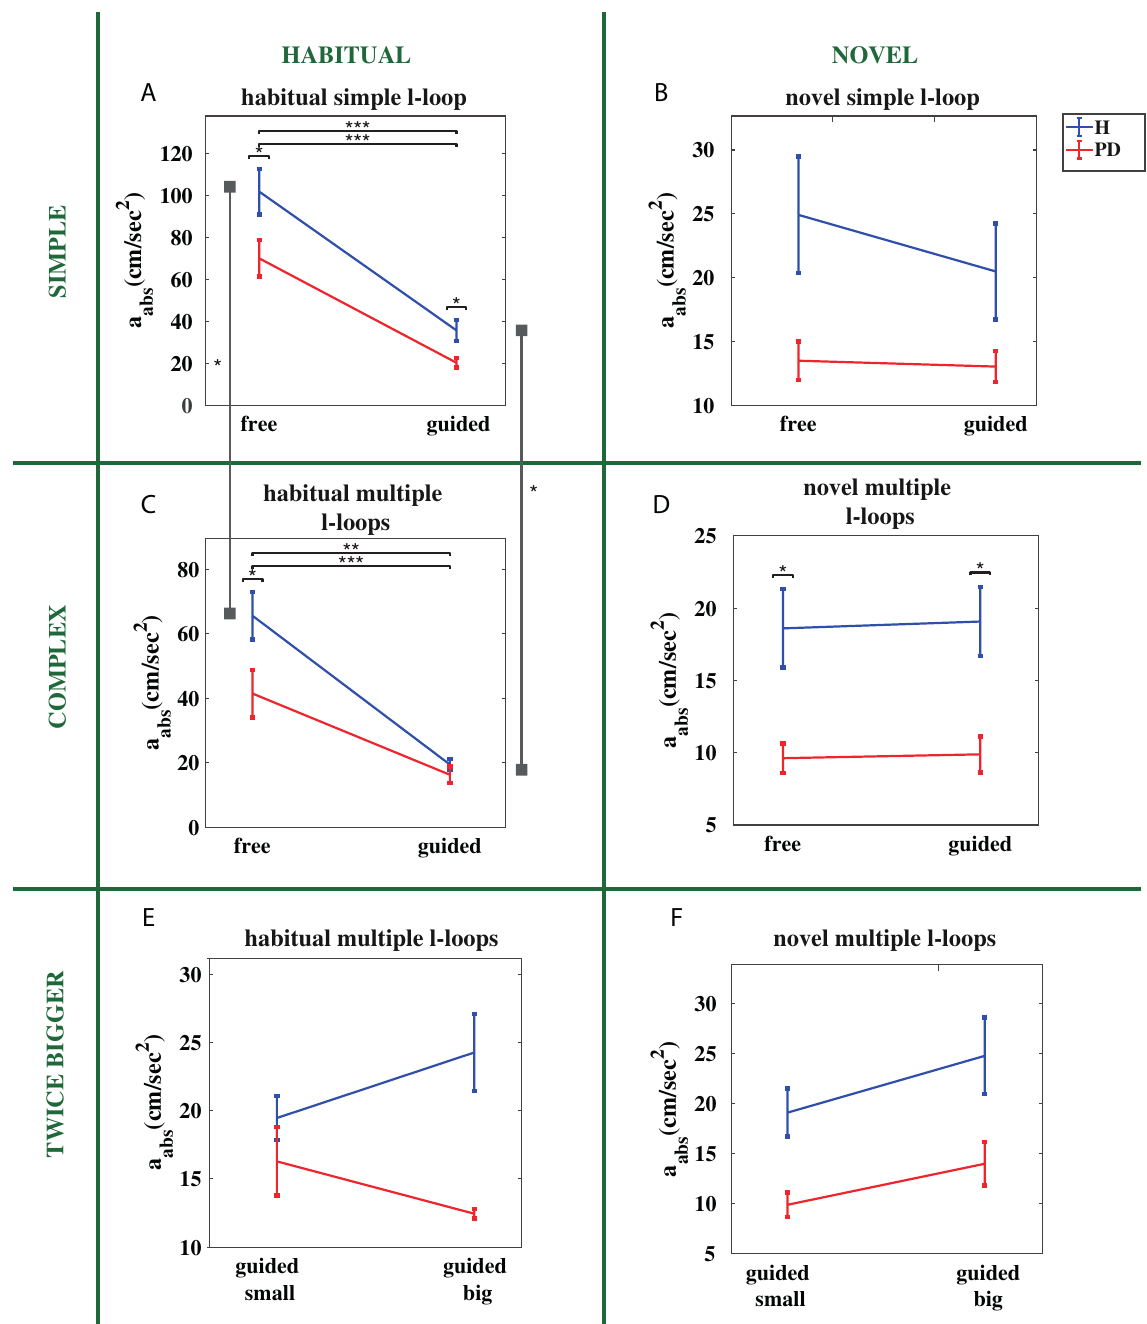
Figure 4. Absolute acceleration (mean ± SEM) across PD patients (red lines) and H subjects (blue lines) for all conditions: ( A ) Habitual simple l-loop, ( B ) Novel simple l-loop, ( C ) Habitual multiple l-loops, ( D ) Novel multiple l-loops, ( E ) Habitual multiple l-loops, ( F ) Novel multiple l-loops. Grey and black lines indicate the results of t -tests that gave significant differences. Stars indicate the results of one-tailed t -tests corrected with the FDR procedure (* p < 0.05; ** p < 0.01; *** p <